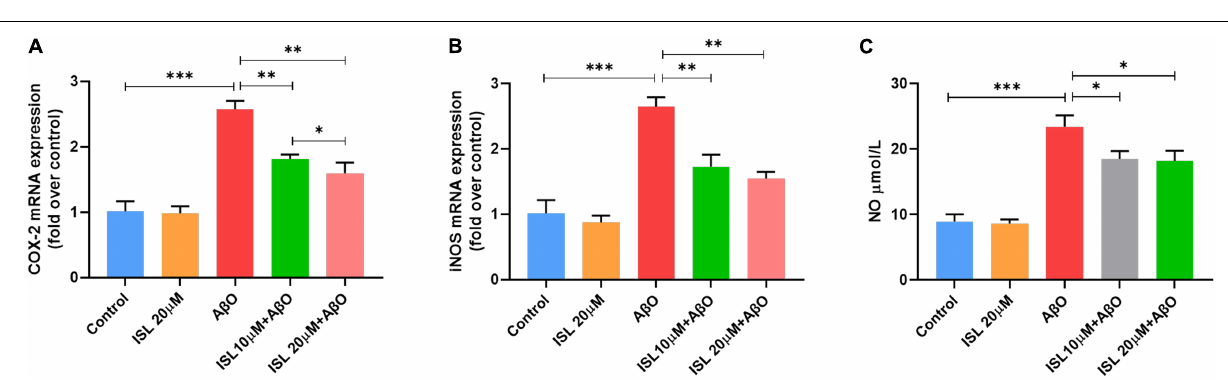
FIGURE 4 | ISL attenuates oxidative stress in BV2 cells. (A,B) BV2 cells were pre-treated with ISL for 2 h and then treated with 5 µ M A β O for 6 h. The mRNA levels of COX-2 and iNOS were analyzed by qRT-PCR. (C) BV2 cells were pre-treated with ISL for 2 h and then treated with 5 µ M A β O for 24 h. The production of NO was assessed using the Griess reaction assay. ∗ p < 0.05, ∗∗ p < 0.01, ∗ ∗ ∗ p < 0.001. n = 6 per